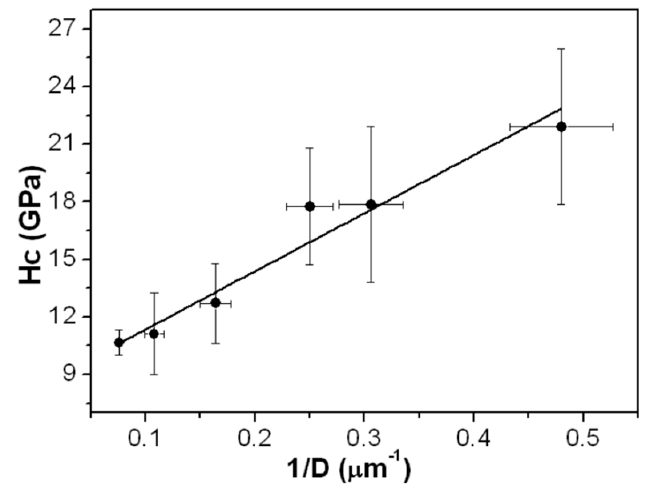
Figure 9. Composite hardness (Hc) of the film-substrate composite system versus the inverse imprint diagonal (1/D) for a film deposited at a substrate temperature of 500 °C.